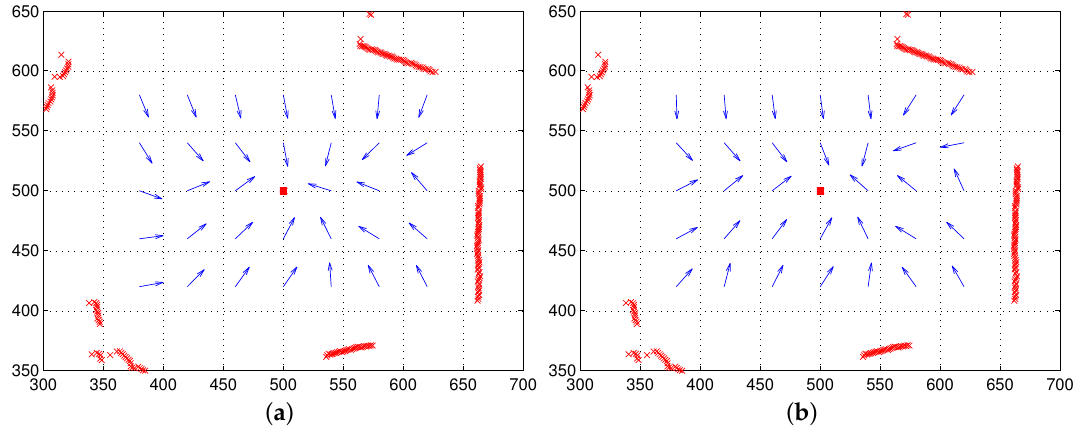
Figure 12. Homing performance with the DID approach ( a ) with a reference compass; ( b ) visual compass without a reference compass; the red box indicates the home position, and arrows show the homing direction at each